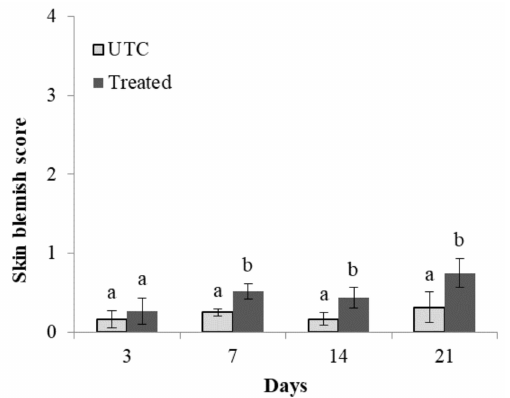
Figure 5. Skin blemish of treated and not treated (UTC) ‘Jiro’ persimmon fruit during storage at 15 ◦ C for up to three weeks. The skin was visually rated as % of the fruit surface a ff ected by blemish based on the following scale: 0 = no blemish (0% blemish); 1 = trace ( < 10% blemish); 2 = slight (11—25% blemish); 3 = moderate (26–50% blemish), and 4 = severe ( > 51% blemish). Data are means ( n = 3) and standard deviations around the mean are shown in error bars. Values with the same letter within each assessment time are not significantly di ff erent using the LSD test at p <